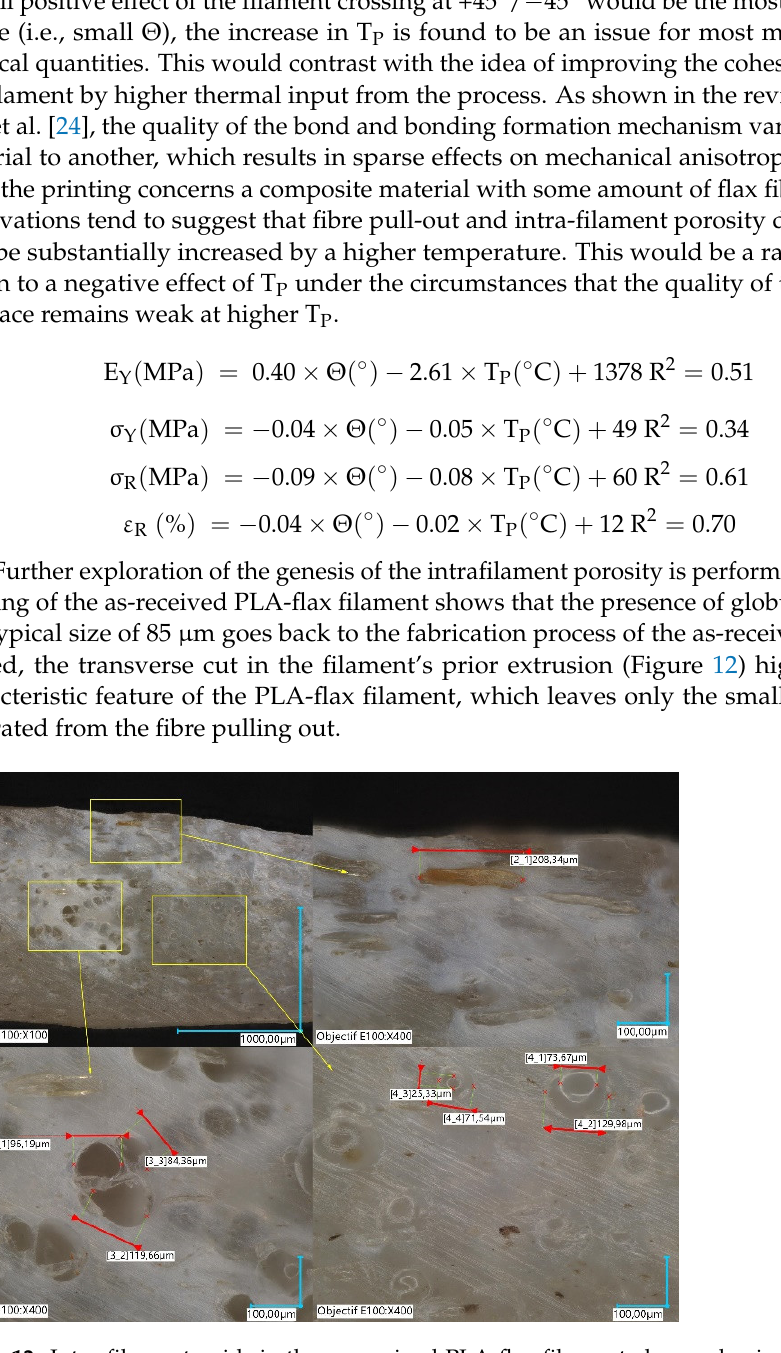
Figure 12. Intra-filament voids in the as-received PLA-flax filament observed using the Keyence VHX 7000 microscope.